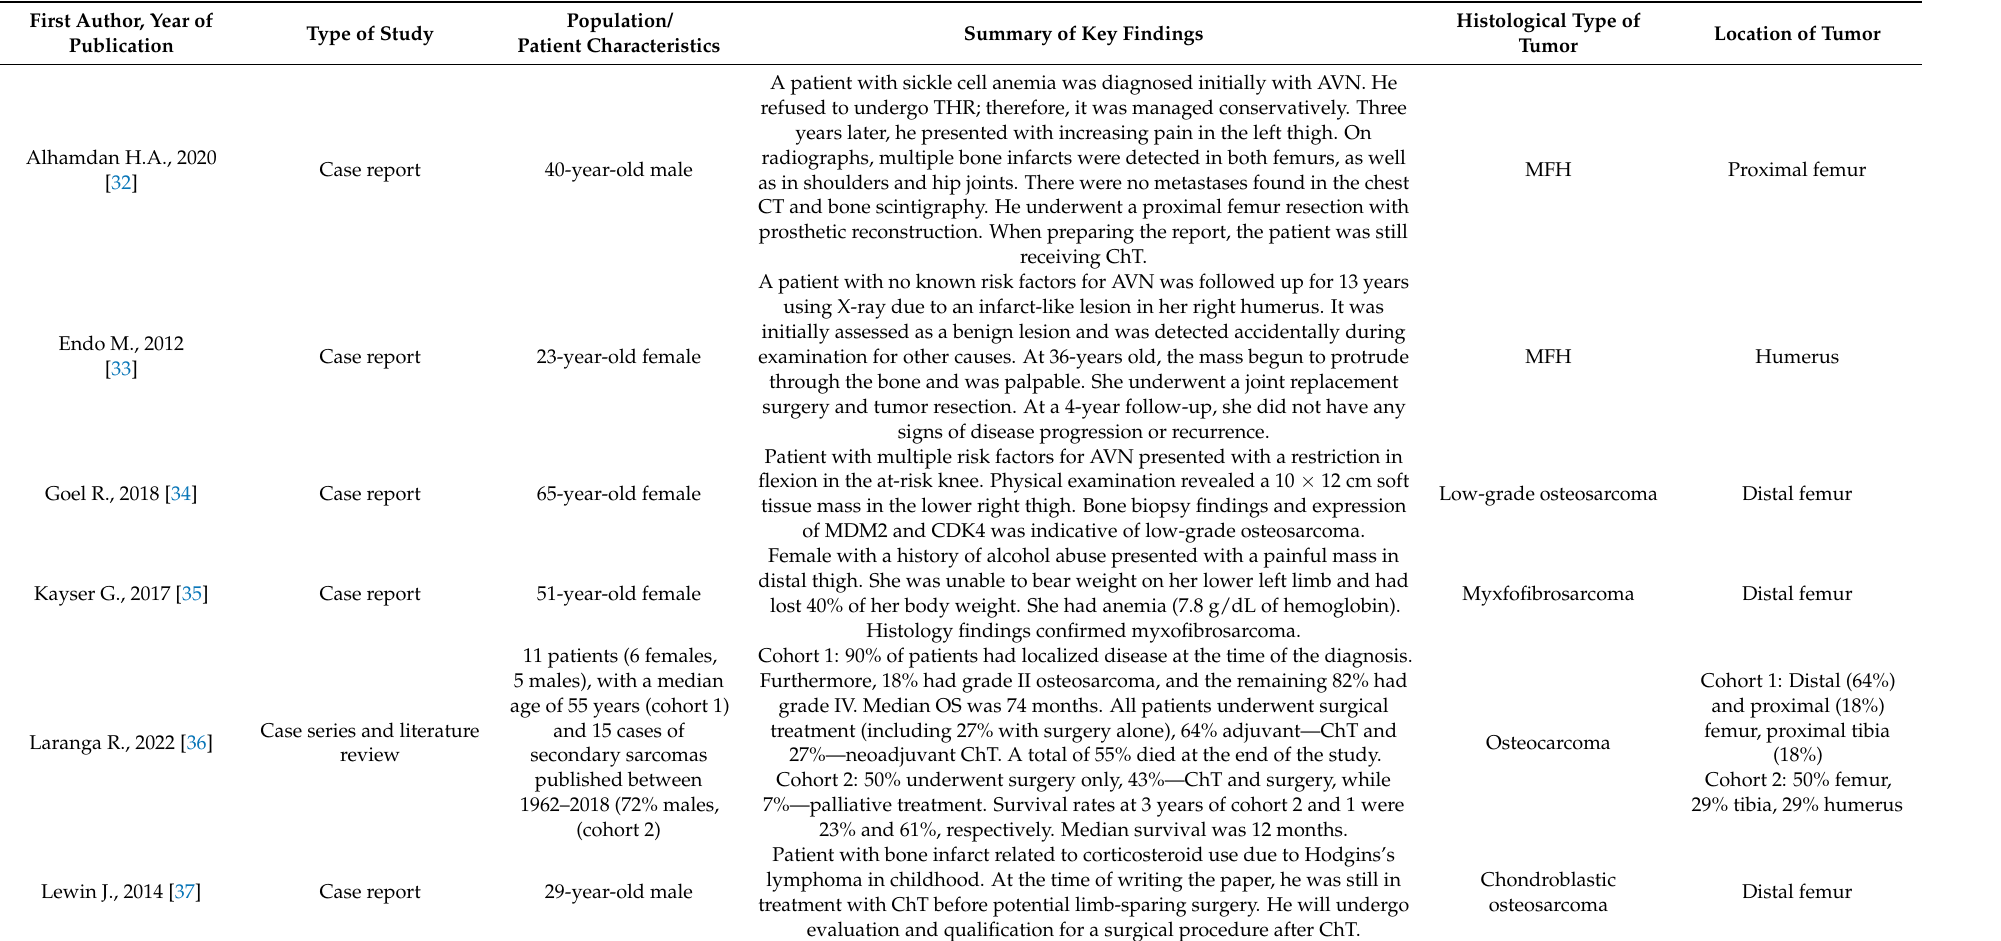
Table 5. Overview of